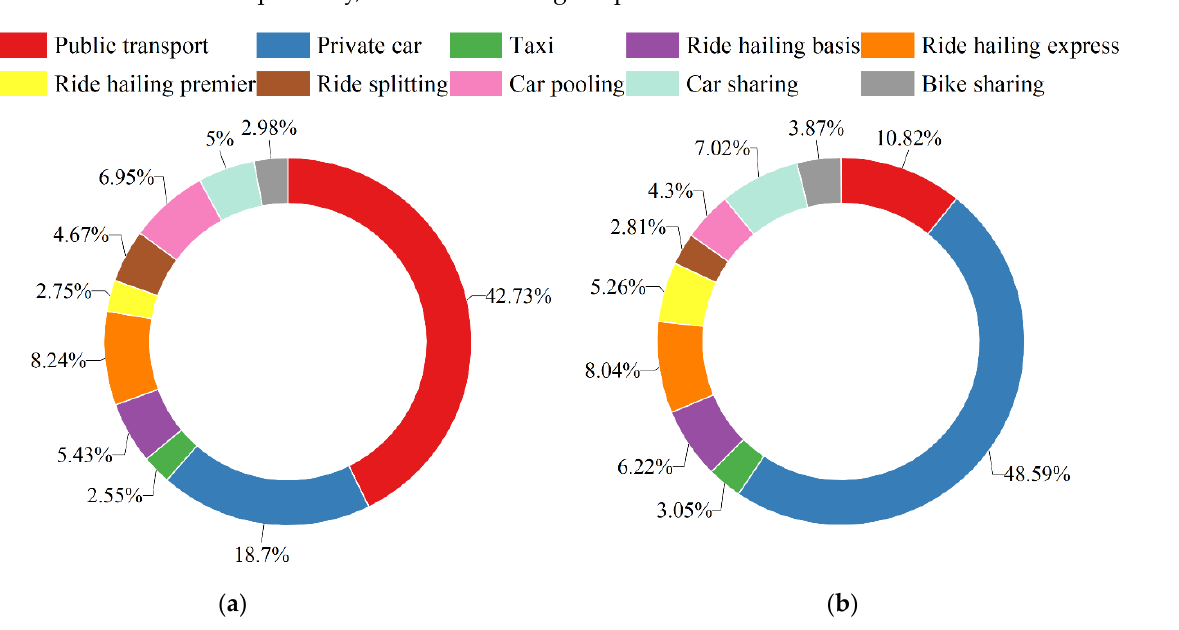
Figure 5. Travel mode choice before and during the COVID-19 pandemic. ( a ) Before the COVID-19 pandemic. ( b ) During the COVID-19 pandemic.